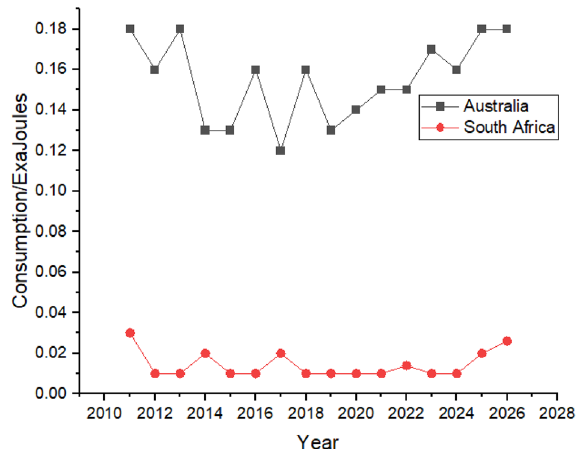
Figure 14. Hydroelectricity consumption in Australia and South